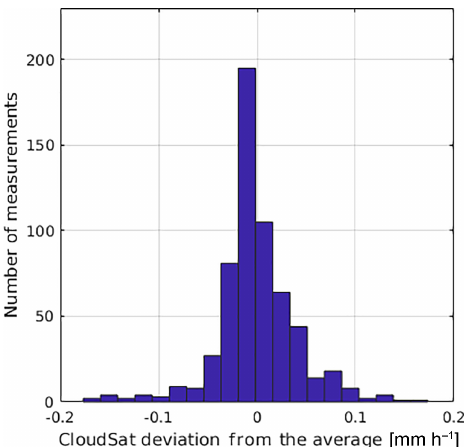
Figure A3. Distribution of the deviation from the averaged values of CloudSat snowfall rate for all vertical levels. The deviation from the average is calculated for each considered vertical bin and for each